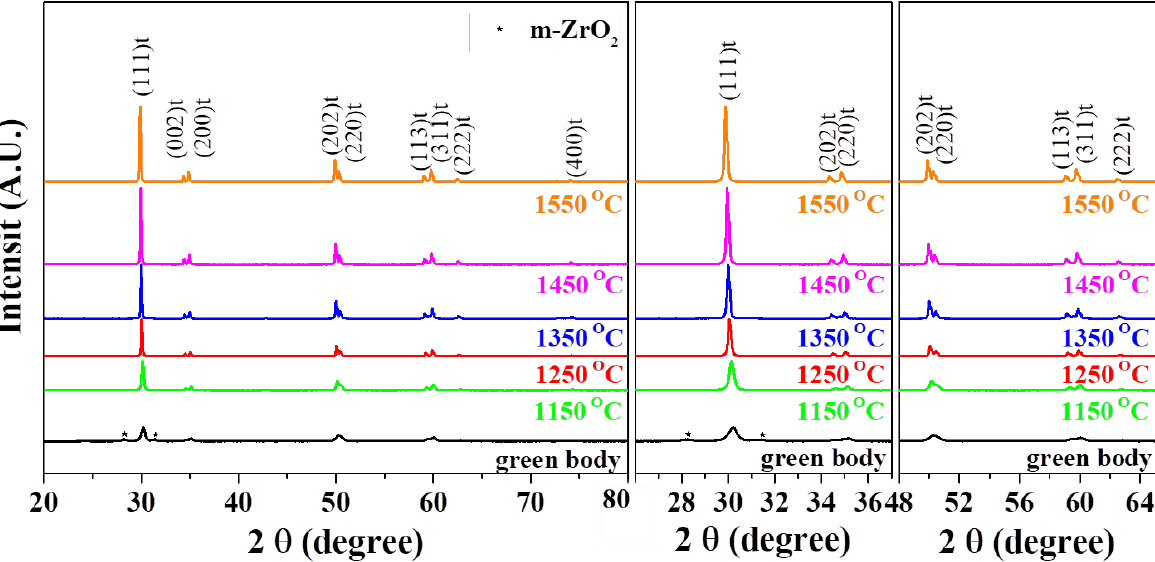
Figure 4. SEM images of 3YSZ 3D-printed sintered body according to sintering temperature. The inset shows optical images of the 3YSZ 3D-printed sintered body after the sintering process. As the sintering temperature increased, although the shrinkage in diameter ( x and y axis) was almost the same at approximately 14%, a minimum of 25% and a maximum of 30% shrinkage in the thickness ( z axis, additive direction) were observed at 1150 °C and 1450 °C, respectively, as shown in Figure 5a. The volume shrinkage also increased from 45% to 49%. Unlike traditional ceramic sintering processes, thickness shrinkage seems to be the main determinant of volume shrinkage in the sintering process of 3D-printed ceramics. The relative density and grain size of the green body and sintered body of the 3YSZ 3D-printed objects were analyzed according to the sintering temperature, as shown in Figure 5b. A three-step sintering mechanism has been reported based on sintering theory [16]. For 3YSZ, the first stage is carried out at approximately 1150 °C. This stage,